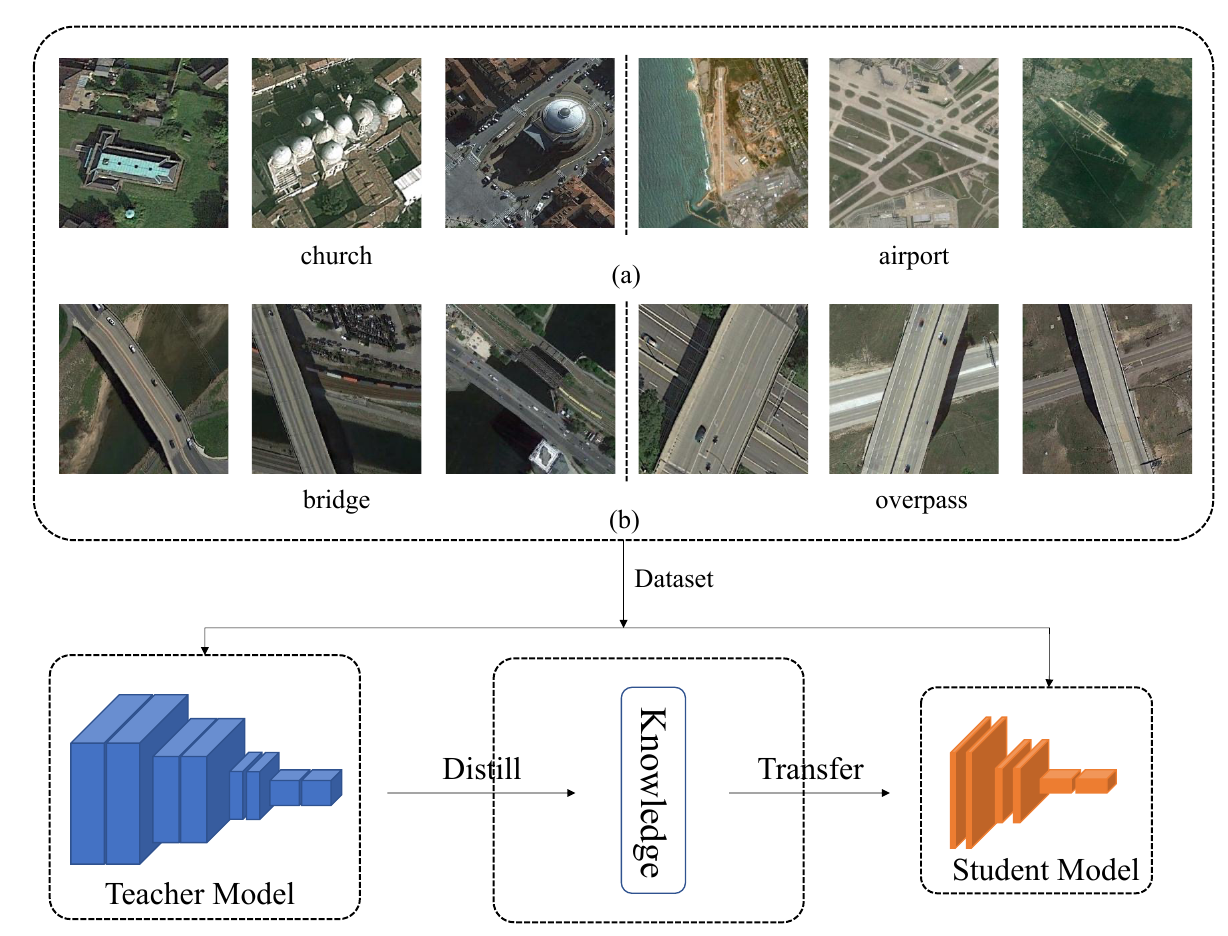
Figure 1. The motivation of the proposed method. ( a ) Various building styles of churches and different shapes of airports can be seen. ( b ) We observe that the images of the bridge seems similar to those of the overpass. Unlike the complicated deep models, light models are unable to deal with such challenges as ( a ) within-class diversity and ( b ) between-class similarity. We aim to obtain a lightweight network by distilling valuable knowledge from the complicated